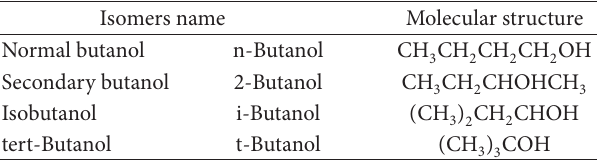
Table 2: Molecular structure of butanol